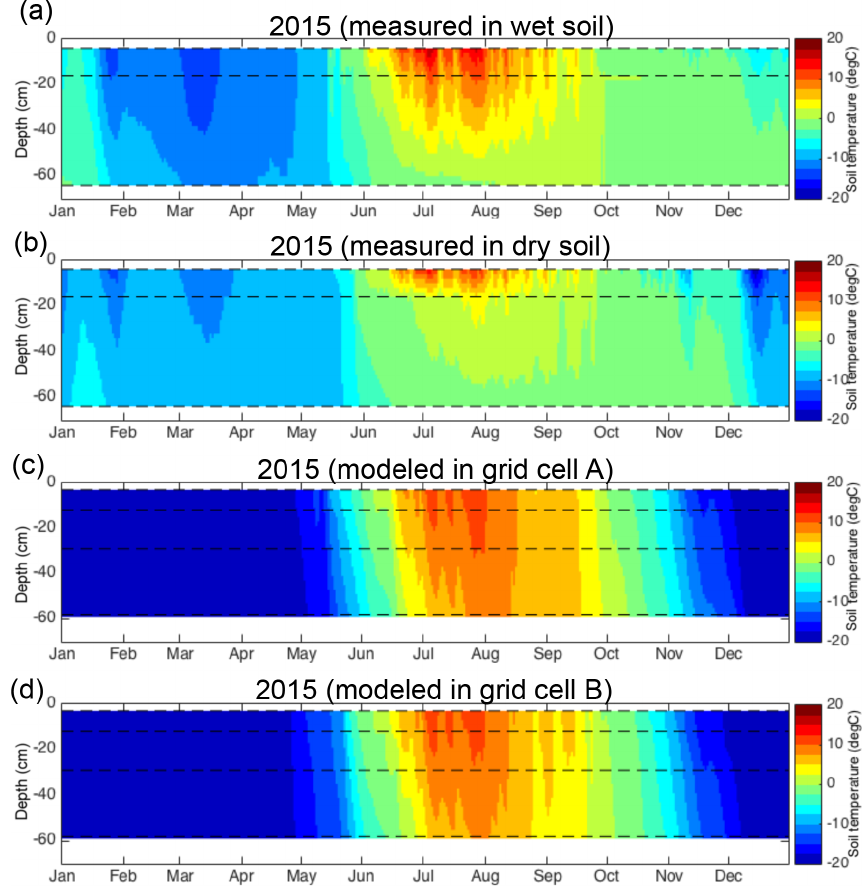
Figure 7. Hovmöller diagrams showing the time evolution of the vertical profiles of daily soil temperature during 2015 from eddy covariance fluxes measured (a) at the wet plot and (b) at the dry plot and from the model data (c) grid cell A and (d) grid cell B. The data were interpolated linearly from the depths where data are available (4, 16, and 64cm in the sensors of redox systems and 3, 12, 29, and 58cm in the